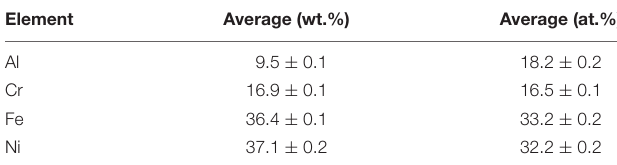
TABLE 3 | Chemical composition of the LPBF coupons measured by EDS. Element Average